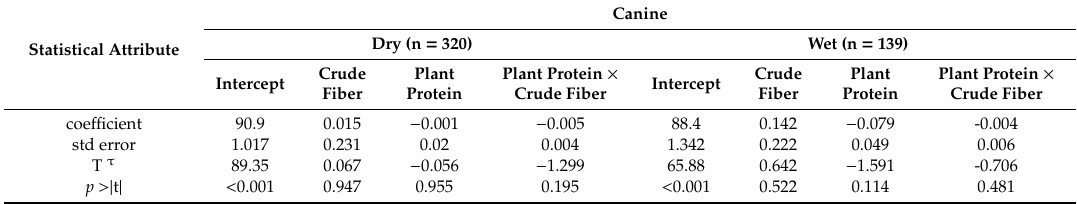
Table 4. The e ff ect of percent of total protein as plant protein and fiber (percent of dry matter) on protein digestibility in the